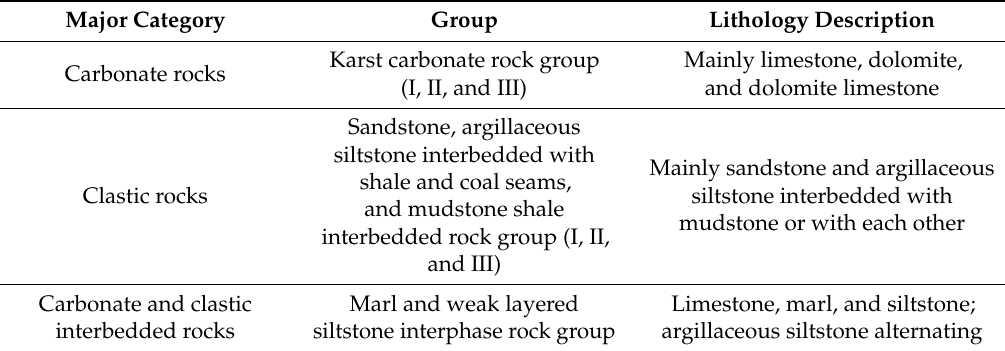
Table 1. Classification of engineering rock groups (Zigui–Badong